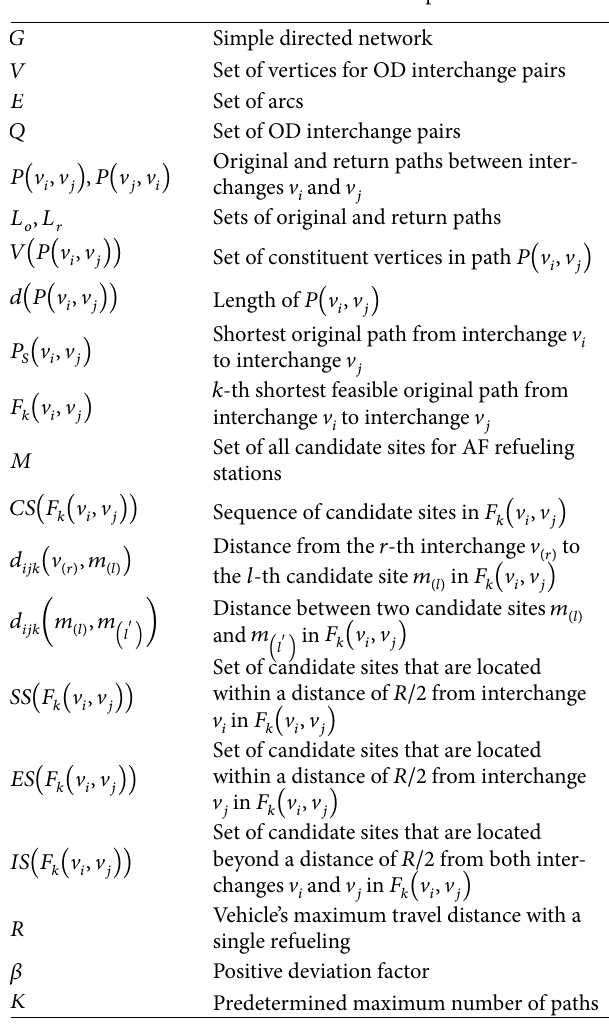
Table 3: Definition of notations and